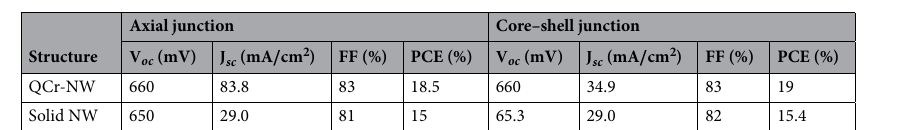
Table 6. The maximum electrical characteristics ( V oc , J sc , FF and PCE) of the axial and core–shell junctions for the proposed QCr-NW and conventional solid NW structures at SRV ∼ 1 cm/s.